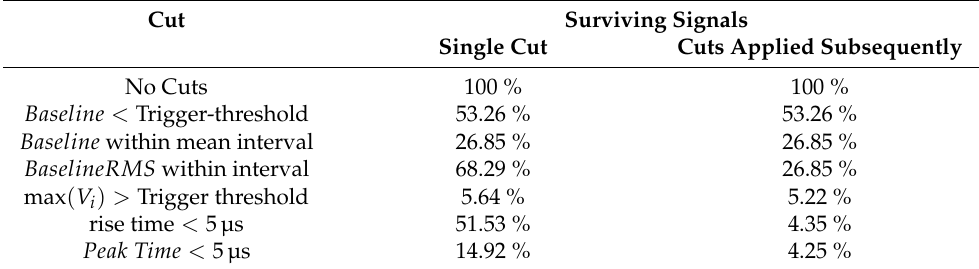
Table 3. Fraction of analyzed waveforms rejected for each data cleaning cut for a run containing spark